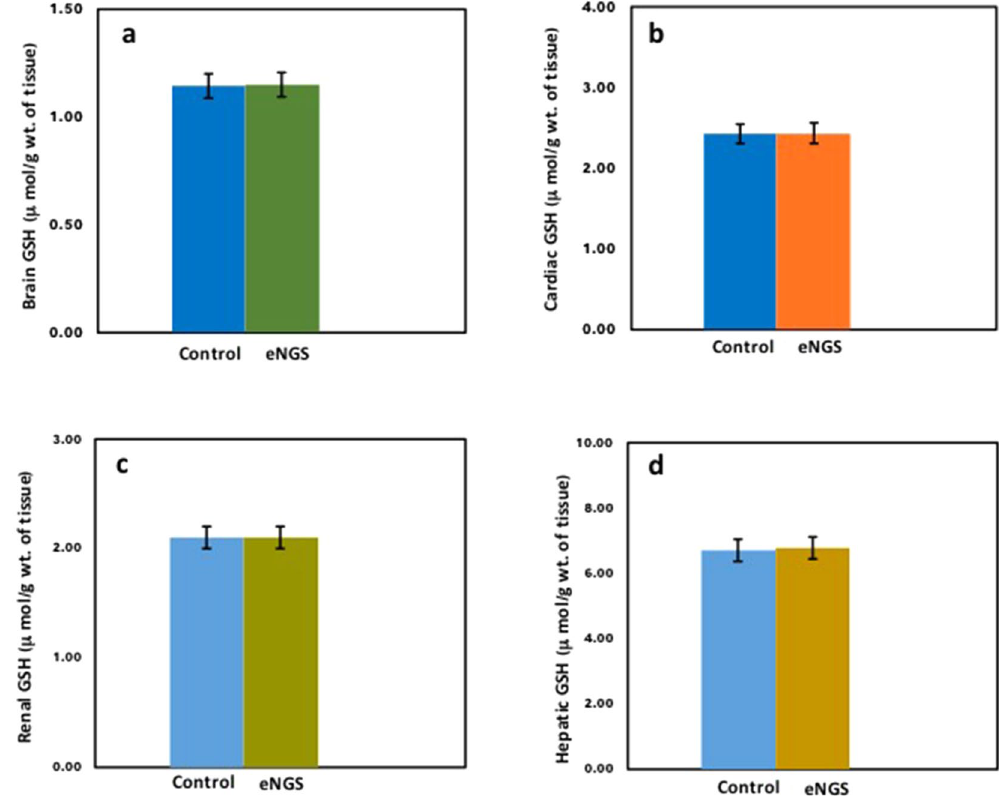
Figure 7. Effect of eNGS (300 mg/Kg/ p.o , once) on glutathione concentration ( μ mol/g wt. of tissue) against normal control rats. ( a ) glutathione concentration of brain, ( b ) glutathione concentration of heart, ( c ) glutathione concentration of kidney, ( d ) glutathione concentration of liver. Each group contain n = 3 rats and all values were represented as mean ± SD. Value of ‘ p’ less than 0.05 has been considered as statistically